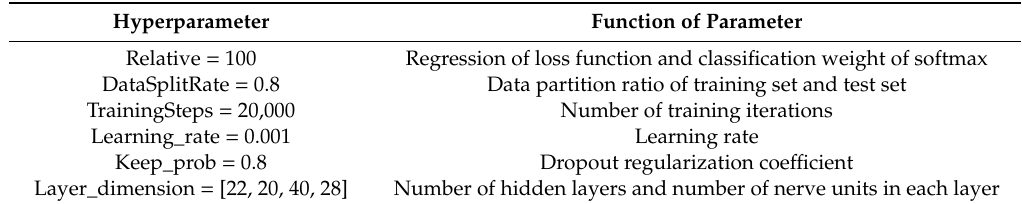
Table 3. Hyperparameters of this model.